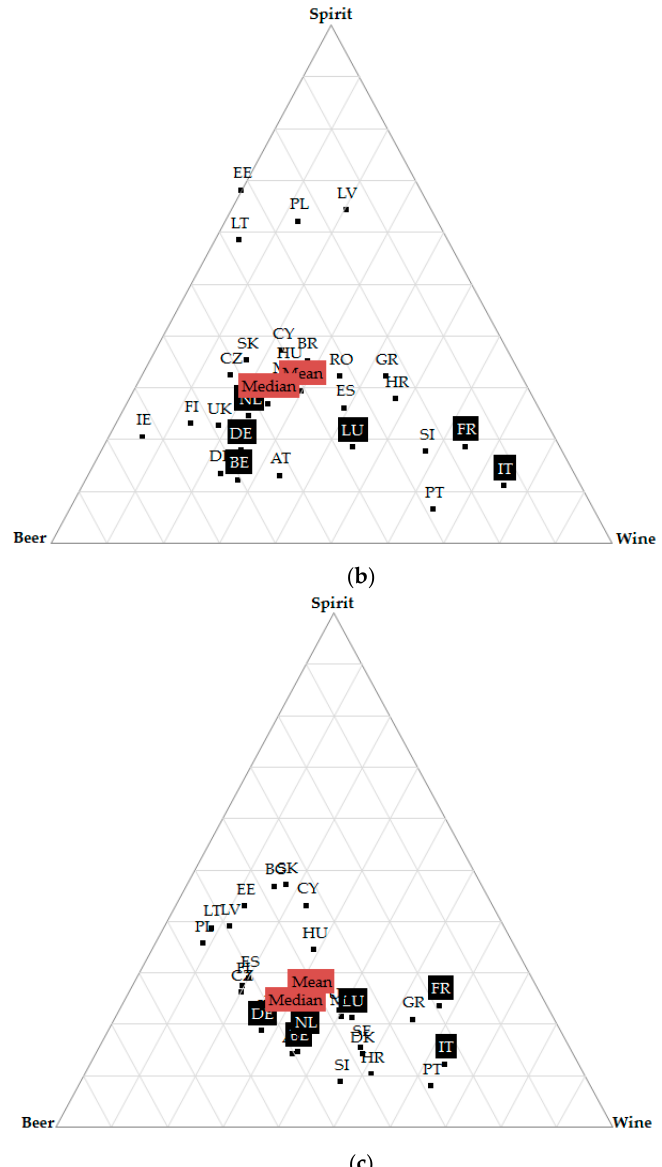
Figure 3. Tertiary plots for the EU-28 alcohol consumption in ( a ) 1970, ( b ) 1990 and ( c ) 2010. Notes: Dark-shaded dots refer to the six founding members. Median and mean of the sample are highlighted in crimson.